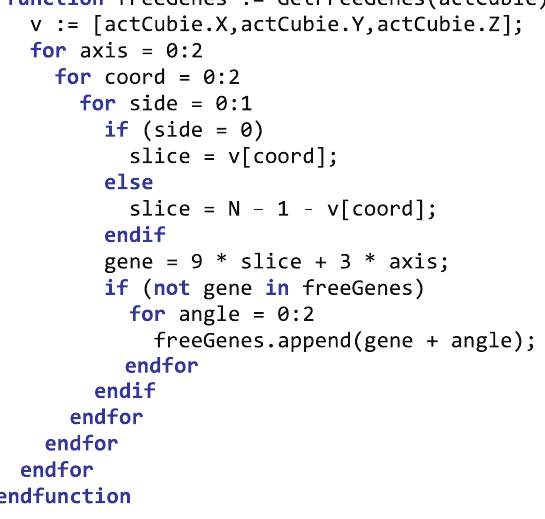
Figure 8: Implementation of function retrieving restricted list of genes (moves) in fl uencing cubies in active cluster